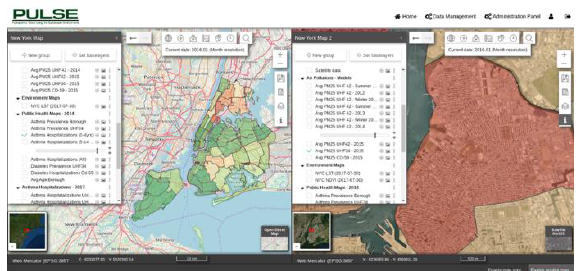
Figure 3. Double map, synched view